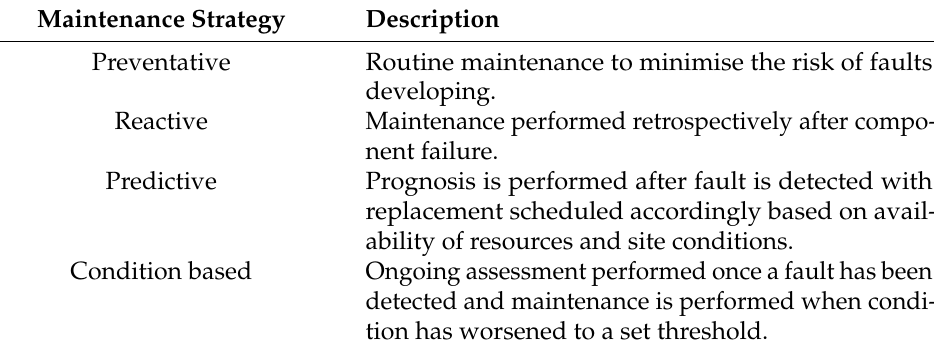
Table 1. Maintenance strategy